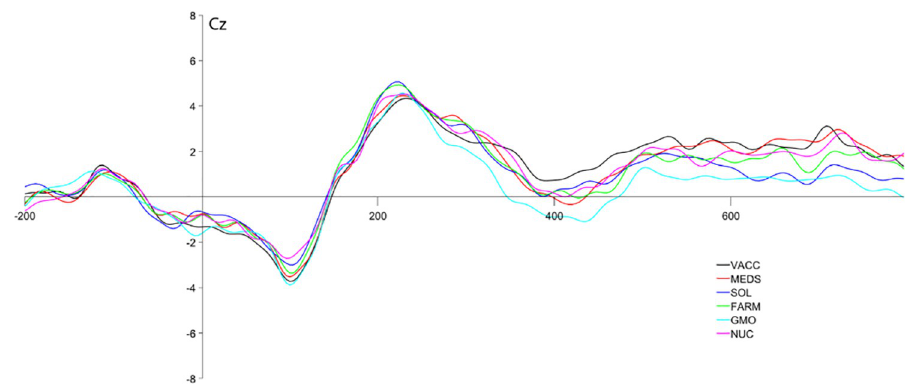
Fig 5. ERP waveform to target-words for six conditions presented during the study on the CZ. VACC = vaccination, NUC = nuclear energy, GMO = GMO technology, MEDS = medicines, SOL = solar energy, FARM = natural